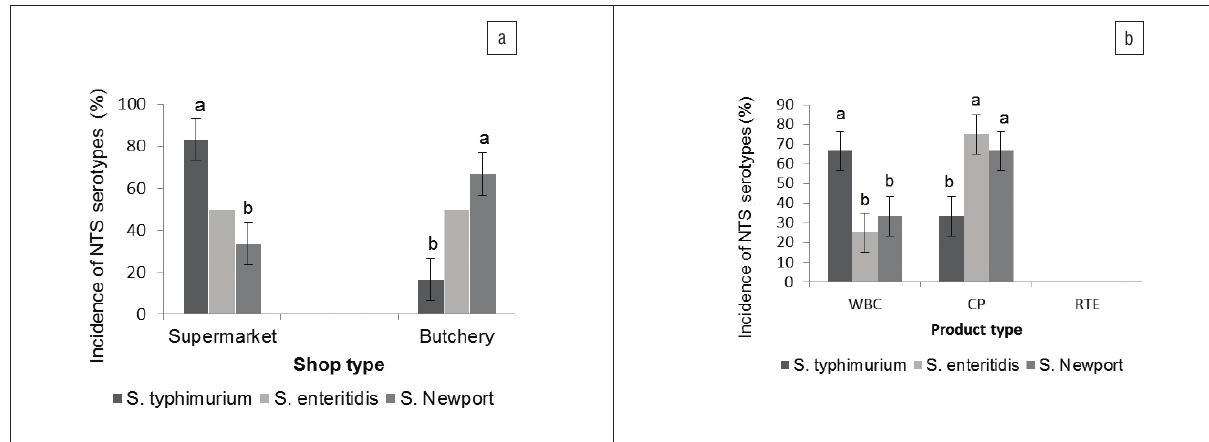
Percentage incidence of non-typhoidal Salmonella (NTS) serotypes by (a) shop type and (b) product